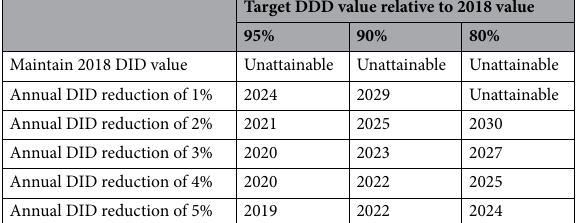
Table 2. Projected attainment of DDD reduction targets according to annual DID reduction rate. DDD, defined daily dose; DID, defined daily doses/1000